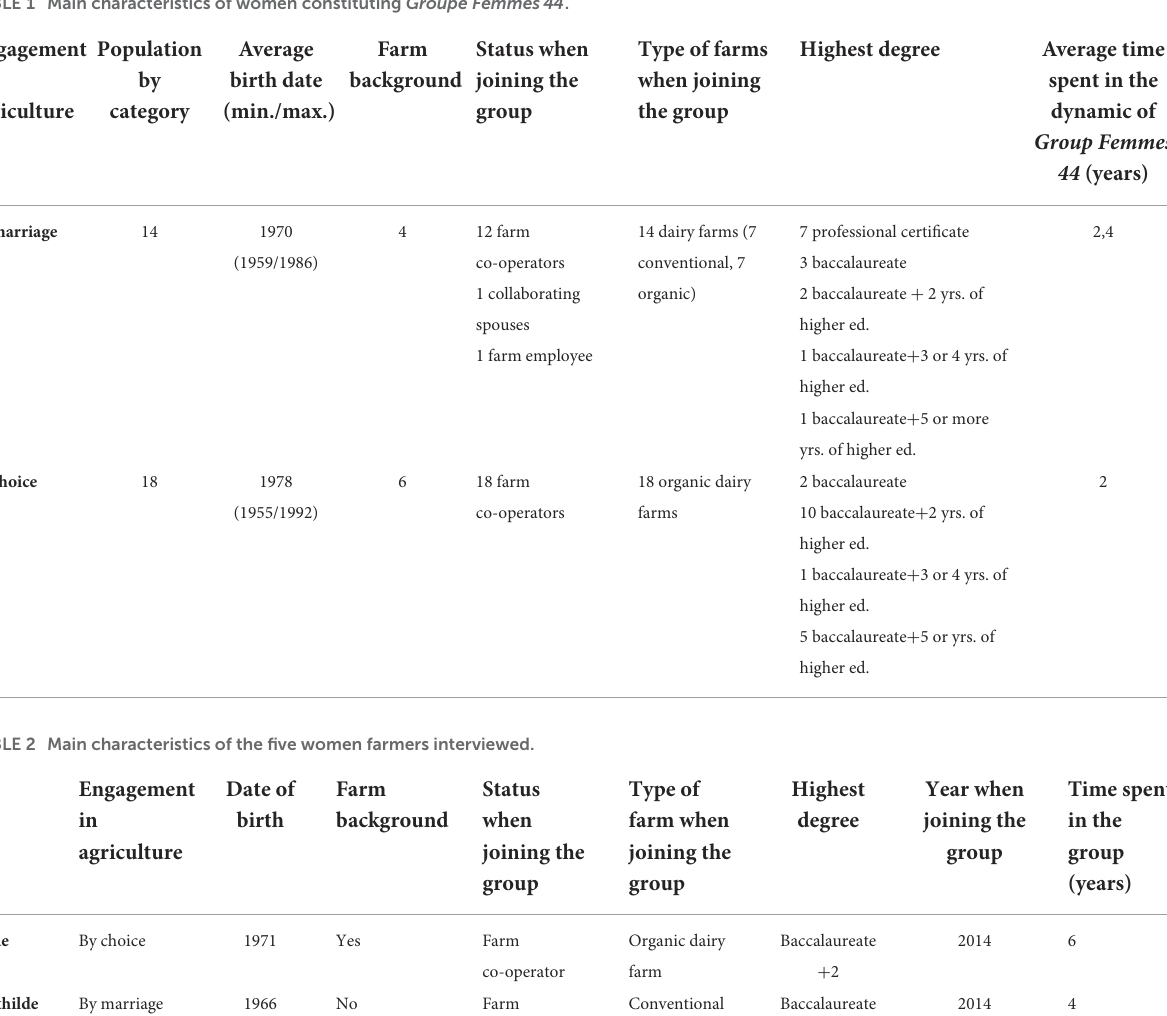
TABLE 1 Main characteristics of women constituting Groupe Femmes 44 .